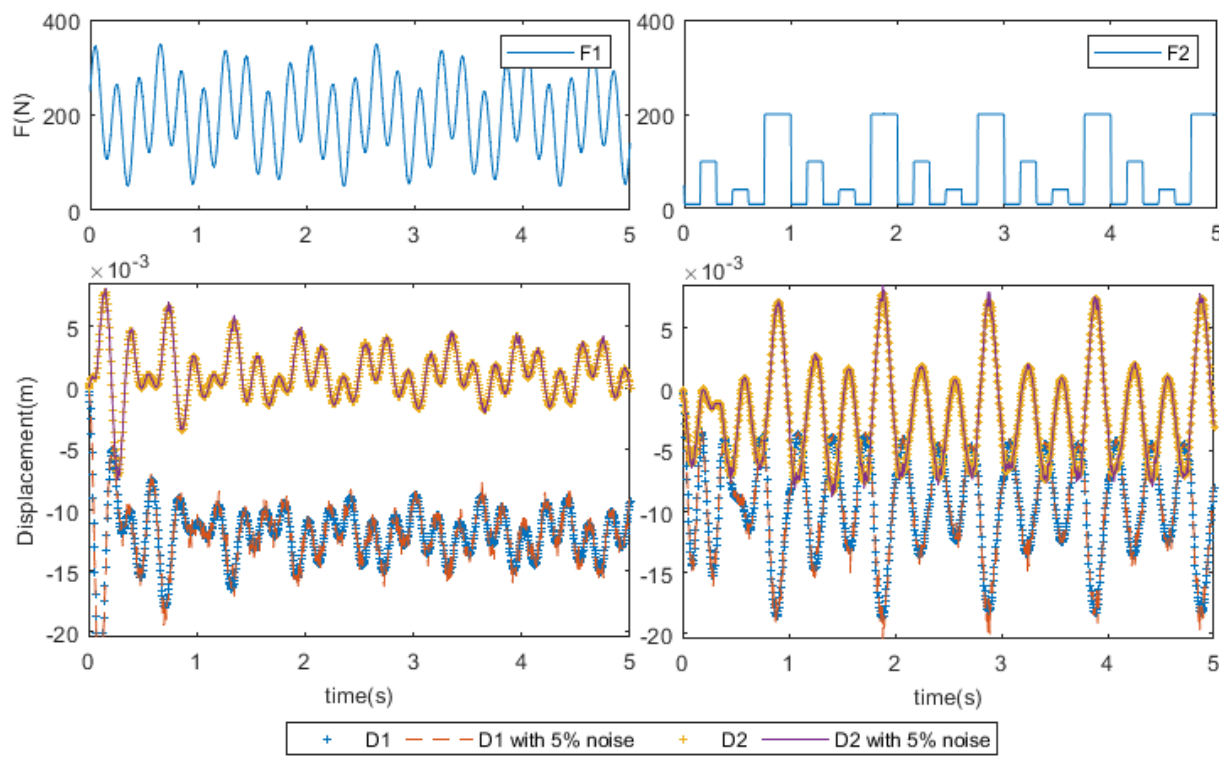
Figure 2. Excitations and corresponding responses.